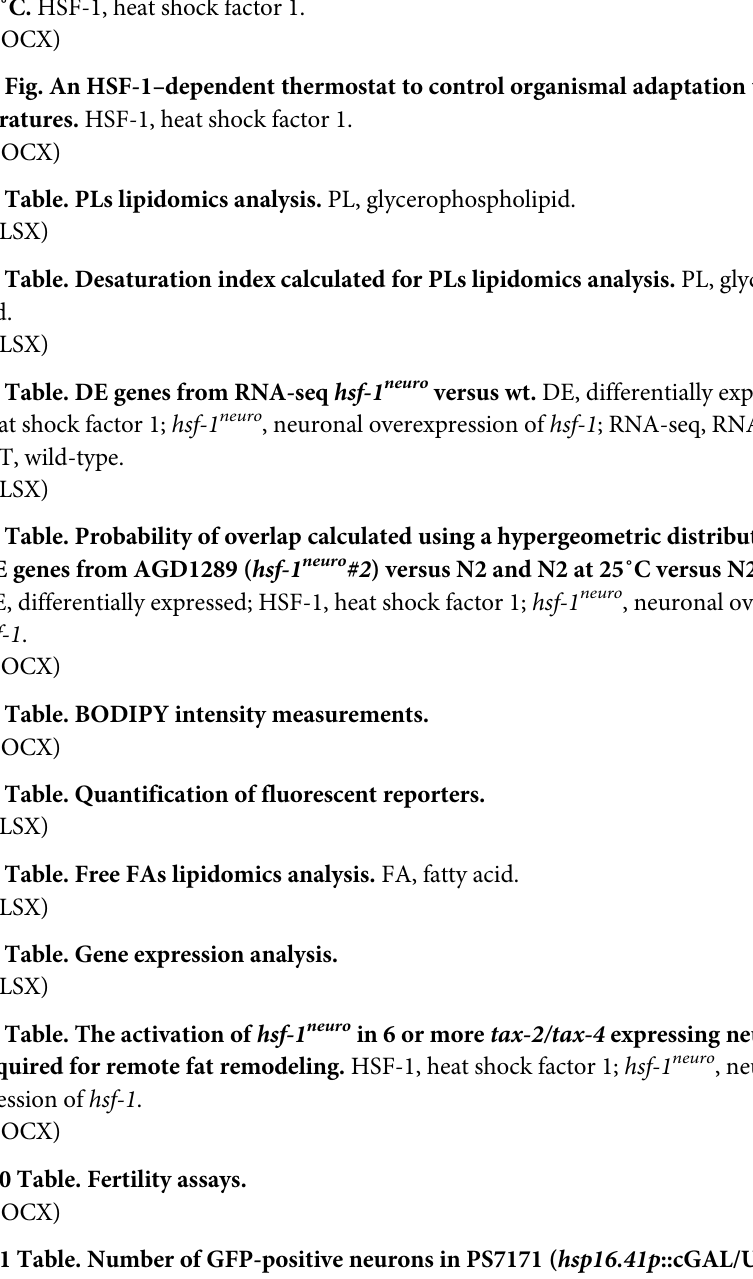
25˚C. HSF-1, heat shock factor 1. (DOCX) S9 Fig. An HSF-1–dependent thermostat to control organismal adaptation to warmer tem- peratures. HSF-1, heat shock factor 1. (DOCX) S1 Table. PLs lipidomics analysis. PL, glycerophospholipid. (XLSX) S2 Table. Desaturation index calculated for PLs lipidomics analysis. PL, glycerophospholi- pid. (XLSX) S3 Table. DE genes from RNA-seq hsf-1 neuro versus wt. DE, differentially expressed; HSF-1, heat shock factor 1; hsf-1 neuro , neuronal overexpression of hsf-1 ; RNA-seq, RNA sequencing; WT, wild-type. (XLSX) S4 Table. Probability of overlap calculated using a hypergeometric distribution between DE genes from AGD1289 ( hsf-1 neuro #2 ) versus N2 and N2 at 25˚C versus N2 at 15˚C. DE, differentially expressed; HSF-1, heat shock factor 1; hsf-1 neuro , neuronal overexpression of hsf-1 . (DOCX) S5 Table. BODIPY intensity measurements. (DOCX) S6 Table. Quantification of fluorescent reporters. (XLSX) S7 Table. Free FAs lipidomics analysis. FA, fatty acid. (XLSX) S8 Table. Gene expression analysis. (XLSX) S9 Table. The activation of hsf-1 neuro in 6 or more tax-2/tax-4 expressing neurons is required for remote fat remodeling. HSF-1, heat shock factor 1; hsf-1 neuro , neuronal overex- pression of hsf-1 . (DOCX) S10 Table. Fertility assays. (DOCX) S11 Table. Number of GFP-positive neurons in PS7171 ( hsp16.41p ::cGAL/UASp::GFP) at different growth temperatures. (DOCX) S12 Table. List of primers used in this study. (DOCX) S13 Table. Life span assays data.